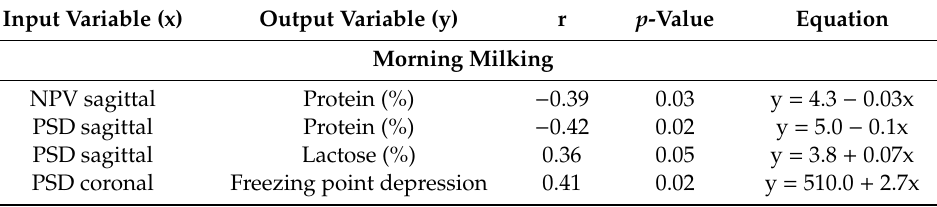
Table 5. Correlations (Pearson Product Moment) among quantitative echotextural variables of the mammary gland parenchyma and physicochemical properties of milk samples collected during the morning and evening milking of 30 Holstein-Friesian cows. Correlations are for echotextural characteristics of the udder determined before milking. NPV: Numerical pixel value; PSD: Standard deviation of pixel values or pixel